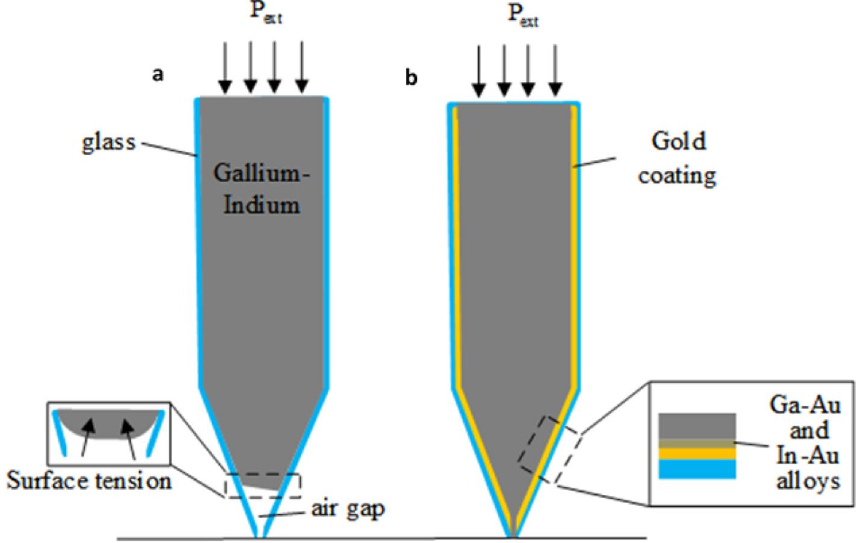
Figure 1. Experimental Scheme. ( a ) When external pressure is applied to the liquid EGaIn inside the glass pipette, it proves insufficient in overcoming the surface tension, leaving a gap of air, beyond which it would not fill. Continuing to apply the pressure beyond this point typically results in the explosive shattering of the glass pipette. ( b ) When the glass is coated with gold from the inside, the molecular interactions between the gold coating and the liquid metal enable wetting under pressure. As the pressure increases, the liquid fills up to the pore, while the gold layer is absorbed almost immediately into the metal liquid.